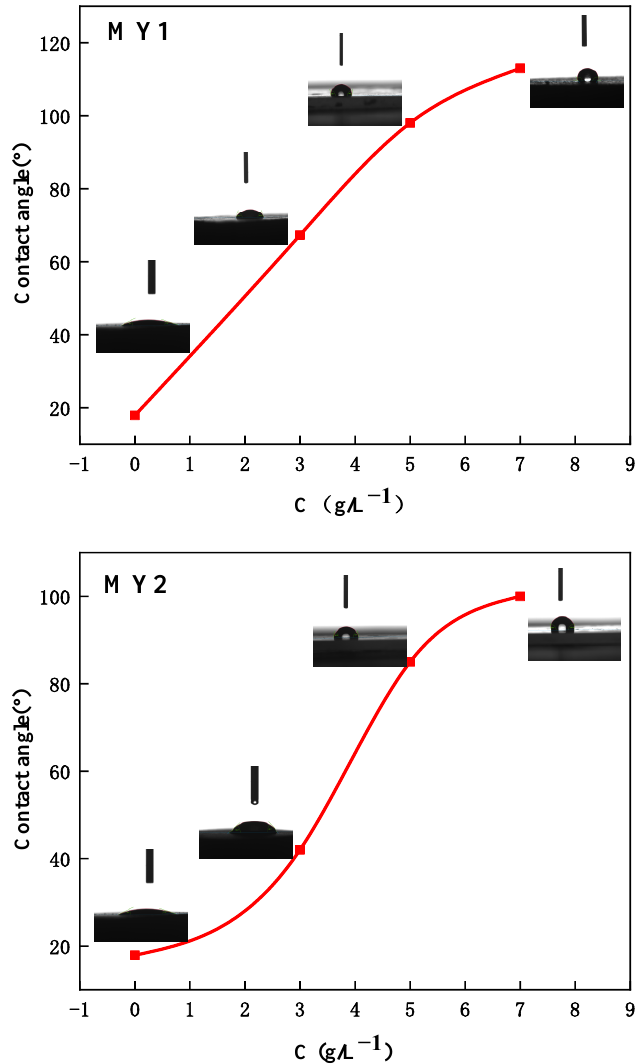
Figure 9. Contact angle test results.